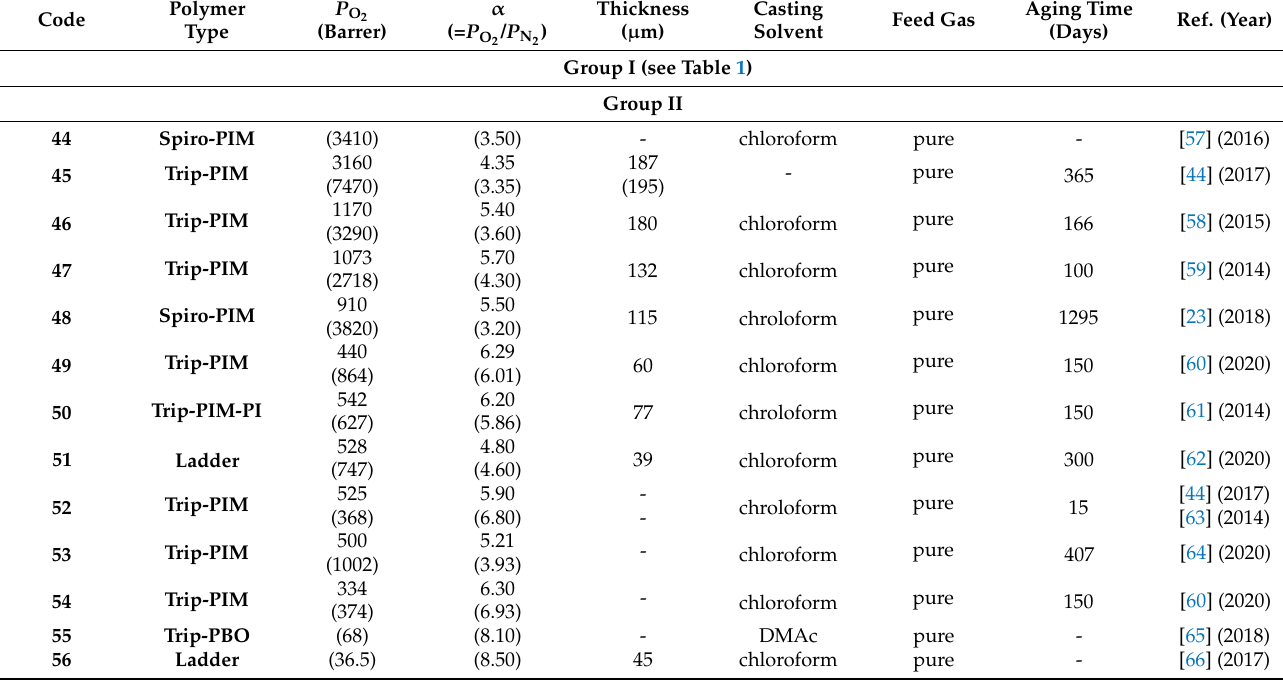
Figure 6. Plots of oxygen permselectivity through polymers, showing the highest α at each P O 2 reported in the literature in 2020 ( ● : after aging, ○ : before aging). For the data and categorization of the plots, see Table 4, and for the chemical structures of the polymers in the plots, see Charts 1 and 4. The small open circles indicate data in Figure 3. [Note] Please compare this figure with Figure 3. You can recognize a big advance between 2013 – 2020 and also no advance of polymers in Group I. Table 4. Categorization and detailed data for the membrane polymers in Figure 6 (all polymers in 2020).